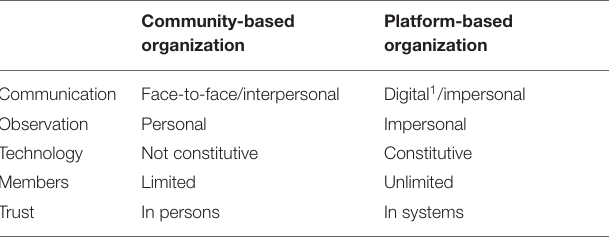
TABLE 1 | Organizational characteristics of the community-based and the platform-based example. Community-based